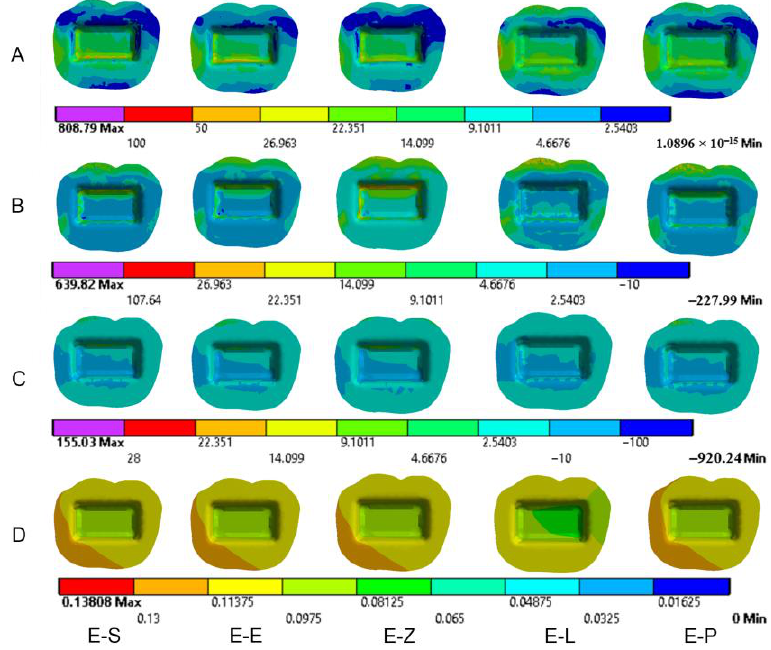
Figure 12. Stress distribution and displacement of cement in all models under oblique loading. ( A ) von Mises stress, ( B ) maximum principal stress, ( C ) minimum principal stress and ( D ) displacement. E-S: zirconia-reinforced lithium silicate ceramic model, E-E: lithium disilicate glass ceramic model, E-Z: translucent zirconia model, E-L: resin nanoceramic model and E-P: polymer-infiltrated ceramic network model.